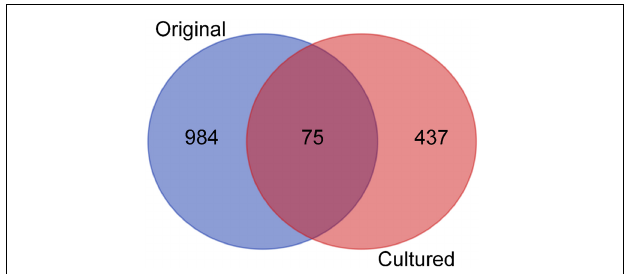
FIGURE 1 | Venn diagram showing the distribution of operational taxonomic units (OTUs) across the original and cultured samples. The three replicates of the original and the cultured samples were combined, respectively, and